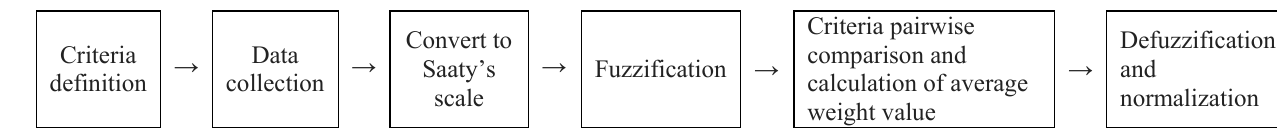
Fig. 2. Steps in the proposed model to determine the